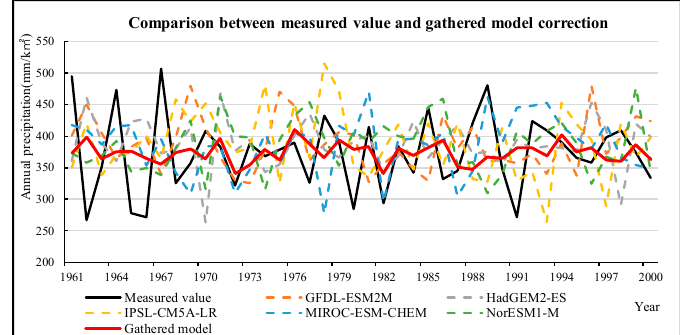
Figure 7. Comparison between the measured value and the gathered model correction (annual precipitation from 1961 to 2000). The red line is the gathered model value, which was closer to the measured value (black line) compared to the different model values (colored lines). Table 5. Index comparison between measured value and gathered model correction (monthly precipitation from 1961 to 2000).